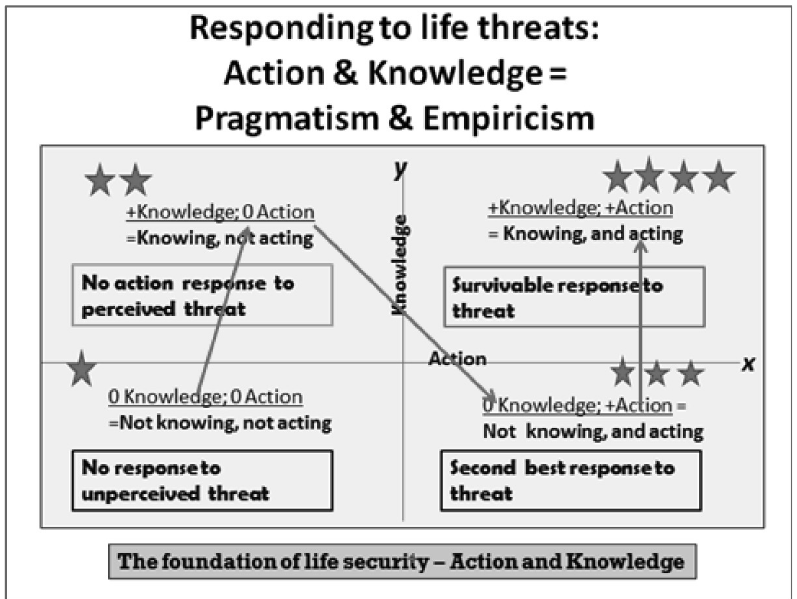
Figure 2: Action and knowledge - importance in life